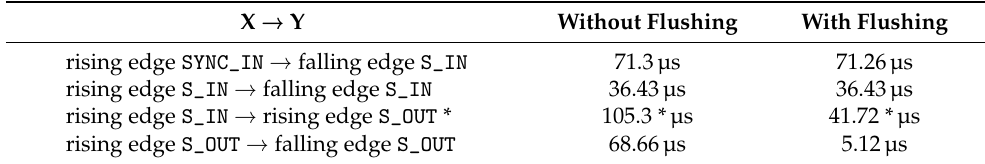
Table 3. Overview of the calculated time delays/latencies. X → Y Without Flushing With Flushing rising edge S_IN → falling edge S_IN 36.4µs 36.4µs rising edge S_IN → rising edge S_OUT * 105.37 *µs